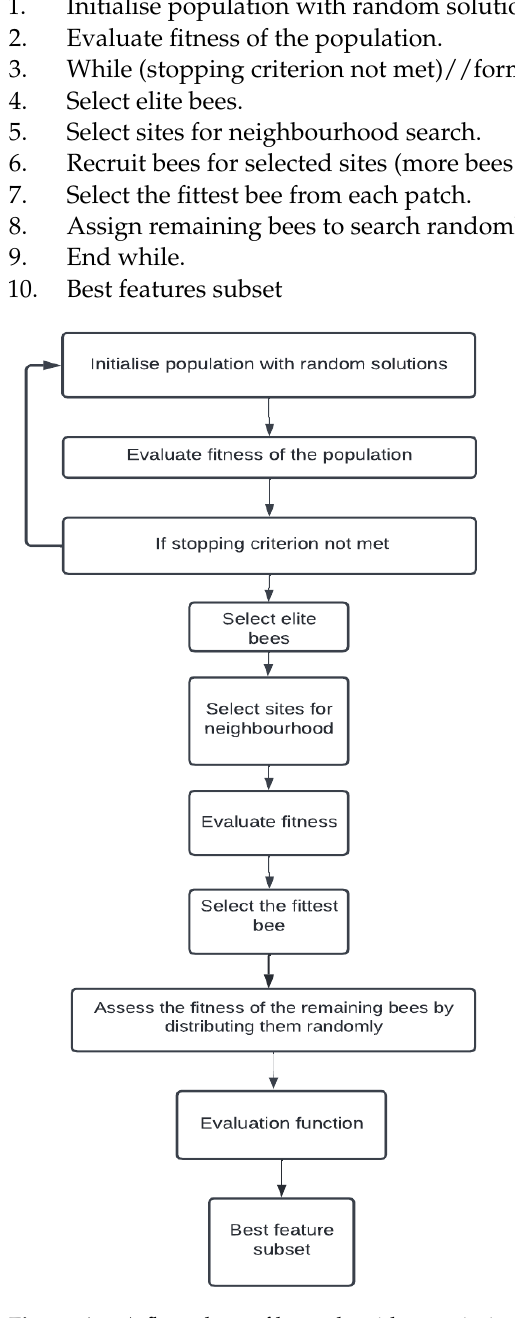
Figure A1. A flow chart of bees algorithm optimization